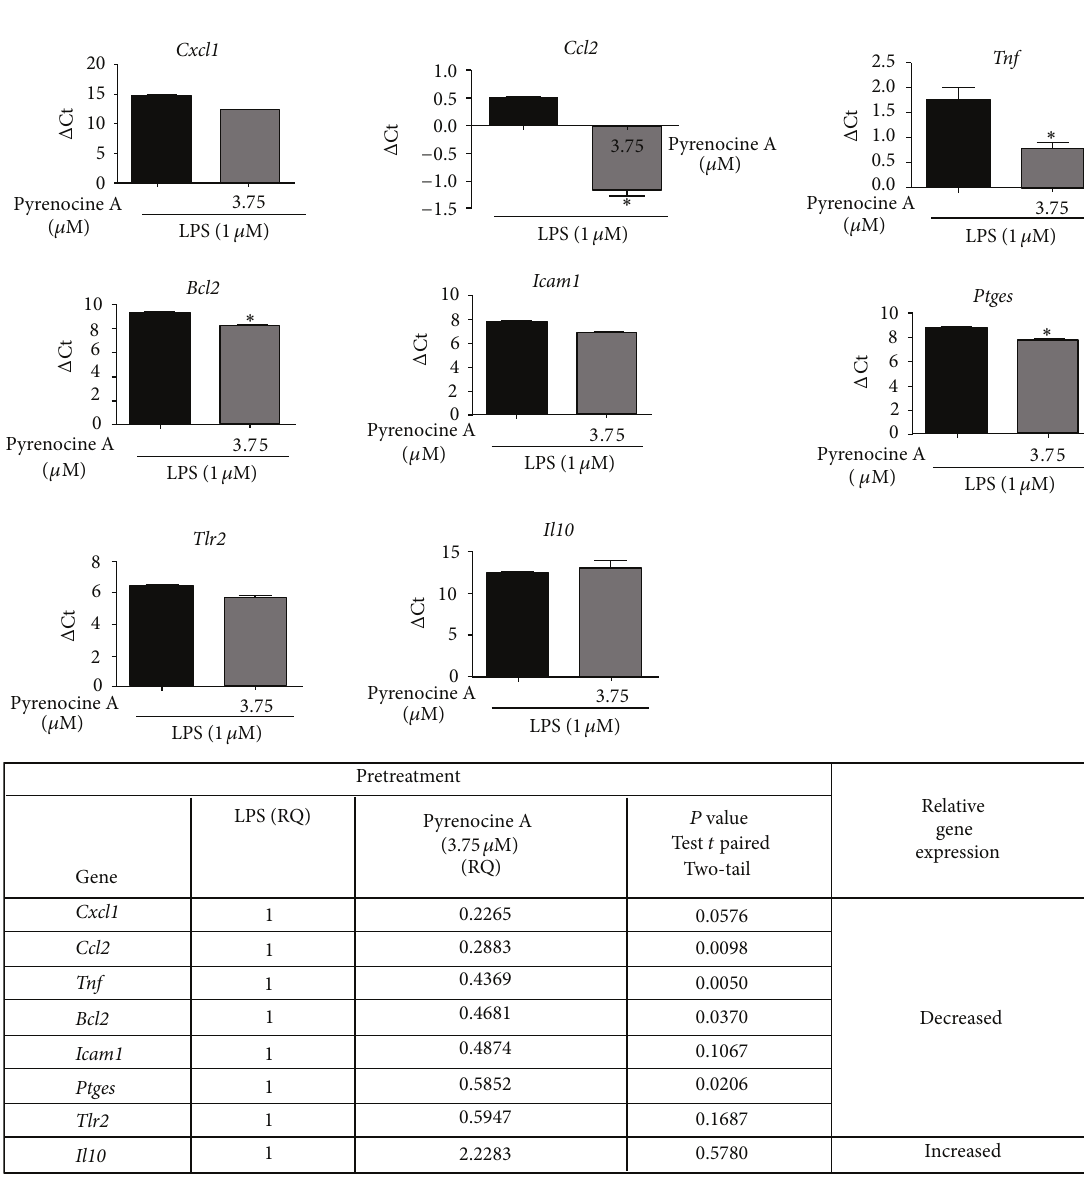
Figure 7: Evaluation of expression of genes related to NF 𝜅 B-mediated transcription-pretreatment procedure. Cells were pretreated with pyrenocine A (3.75 𝜇 M) for 2 h and then stimulated with LPS (1 𝜇 g/mL) during 18h. PCR array plates were purchased from Life Technologies. The results are presented as log Δ Ct to statistical analysis (test 𝑡 ∗ 𝑃 < 0.05 ) and RQ (relative quantification) to show the variation in gene expression (less than 0.6 was considered decreased and more than 1.4 increased). The results show the mean and standard deviation of 3 independent experiments. ∗ 𝑃 < 0.05